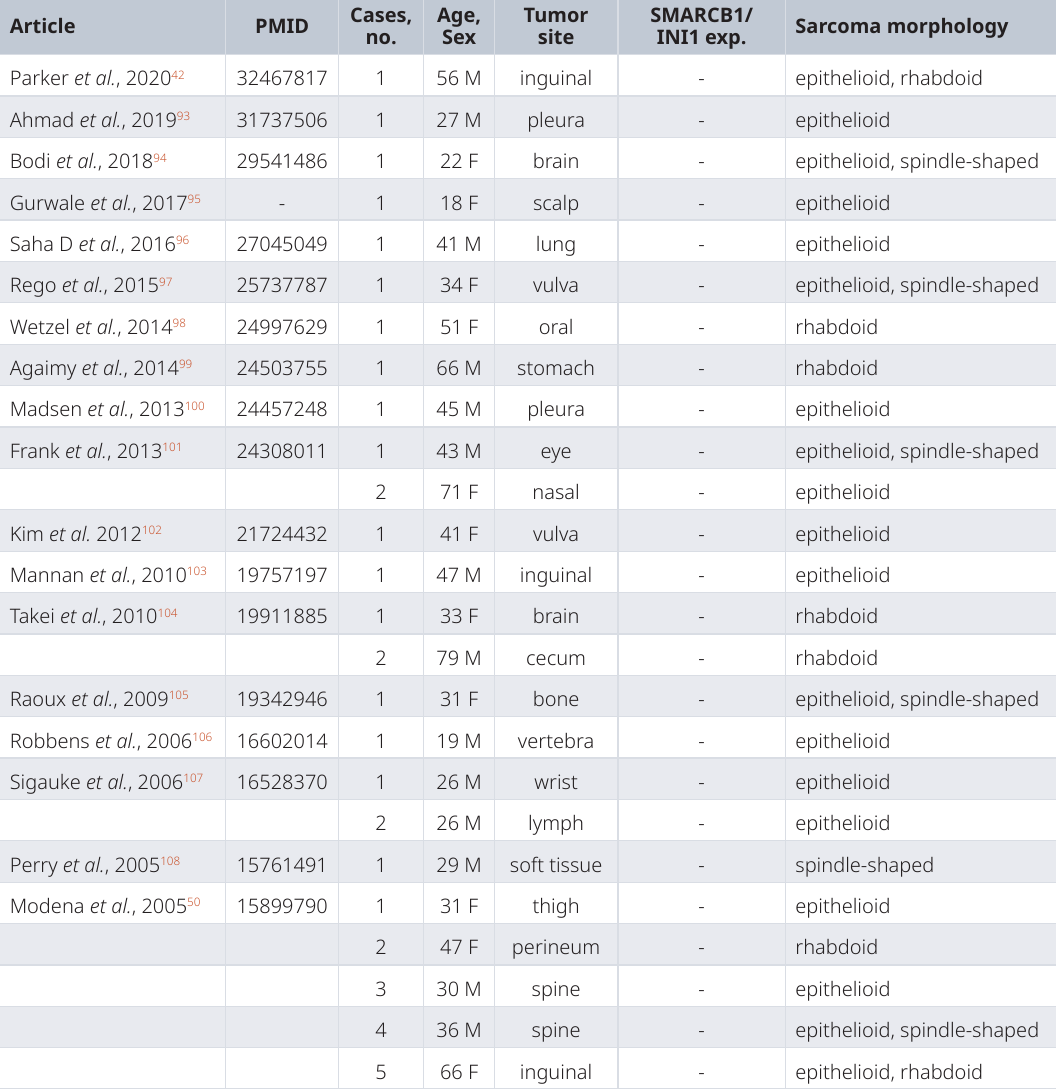
Table 3. Included rare sarcomas reported in single case reports, case series, or systematic reviews, 2000– 2020. Inclusion criteria were as follows: ability to confirm an individual case patient was greater than 18 years of age; documentation of a loss of SMARCB1/INI1 expression by immunohistochemistry or genetic studies; and confirmed sarcomatous histologic tumor type. “ - “ denotes complete, reduced, or mosaic loss of SMARCB1/INI1 expression (exp.). M, male; F,